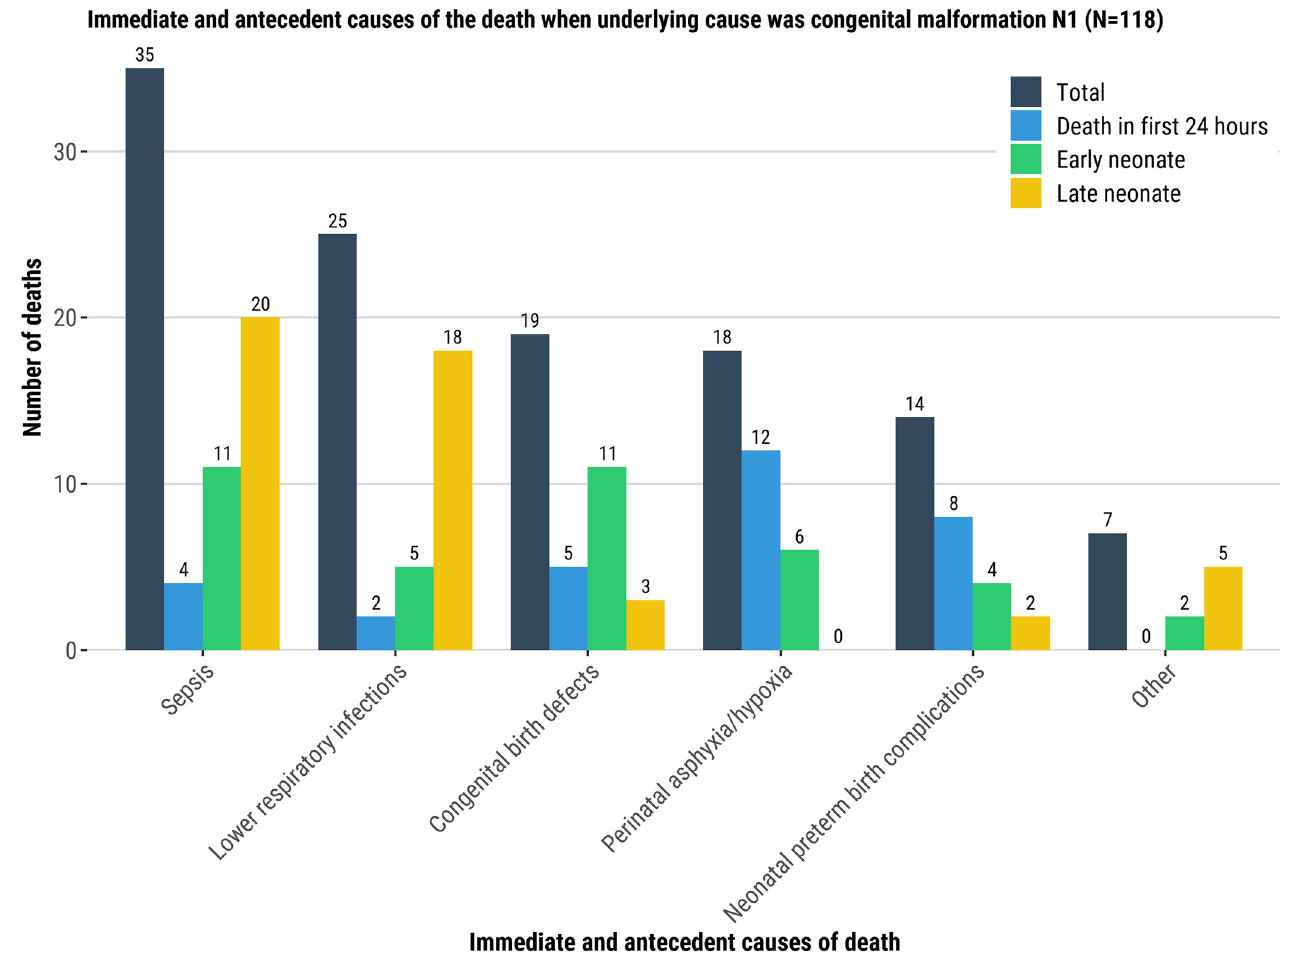
Fig 3. Immediate and antecedent causes of the death when the underlying cause of the death was: Congenital malformation (N1, Fig 3), complication of intrapartum event (N4, Fig 4), infection (N6, Fig 5), respiratory and cardiovascular disorder (N7, Fig 6), and low birth weight and prematurity (N9, Fig 7). There may be multiple immediate and antecedent causes of death for any individual, so the total number of causes may be greater than is listed in the figure titles.